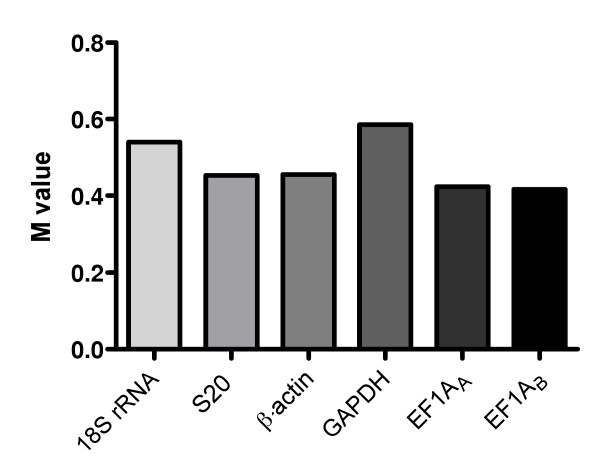
Stability of six genes in gills of Atlantic salmon during smoltification calculated with the geNorm software. geNorm calculates the gene expression stability measure M for a control gene as the average pairwise variation V for that gene with all other tested control genes.